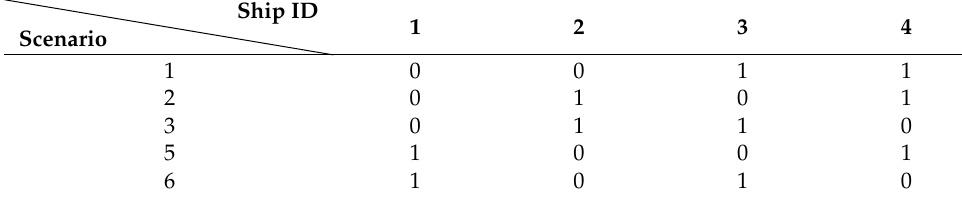
Table 4. Example 1—output of Stage 2.